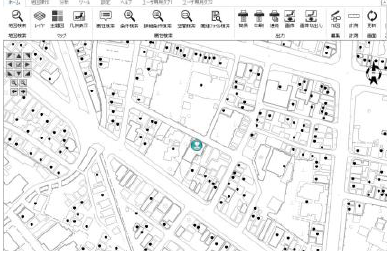
Figure 3. Grasping the number of preschool children by